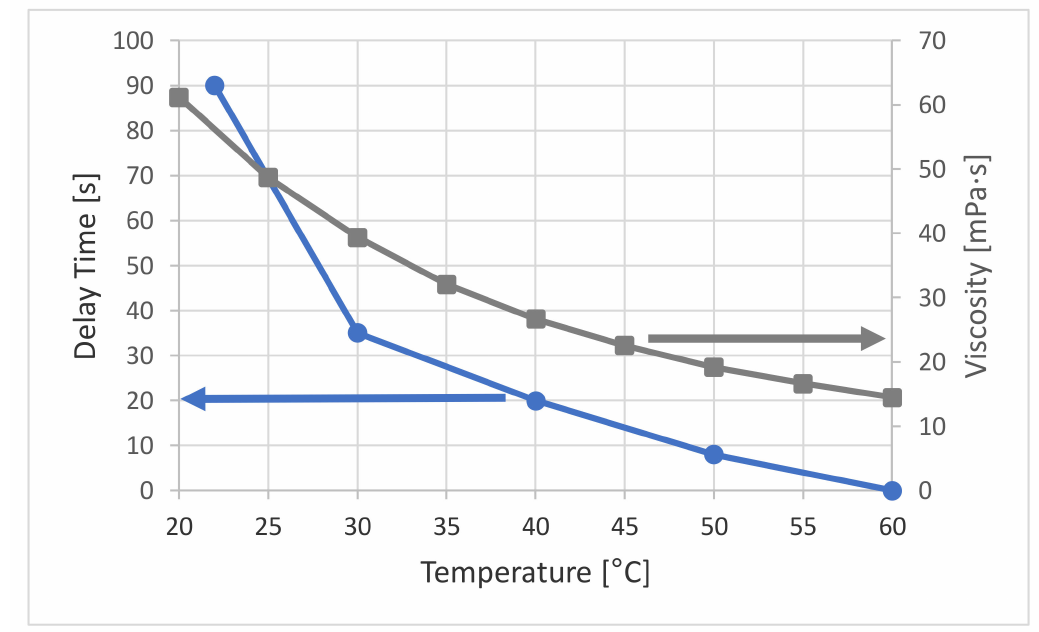
Figure 11. ( Left ) Plot of the required delay time versus the imprint temperature for defect free replication. ( Right ) Tempera- ture dependence of the resist